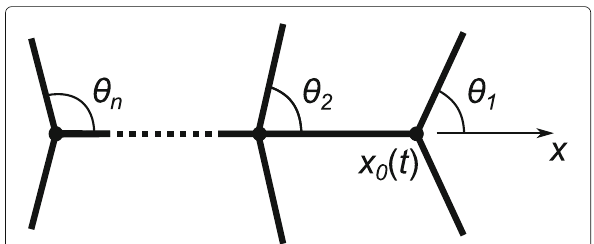
Fig. 18 Sketch of an elongated swimmer equipped with n pairs of legs (cf symmetric Purcell in Table 1)